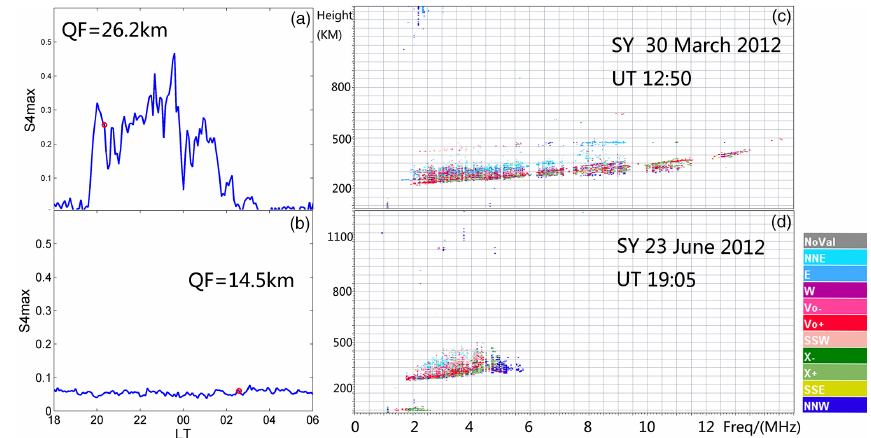
Figure 1. Examples of spread-F events (a, b) with and (c, d) without scintillations at Sanya. The red circles in panels (a) and (c) represent the time when the ionograms shown in right panels were measured. The corresponding QF index is also shown in the panel.